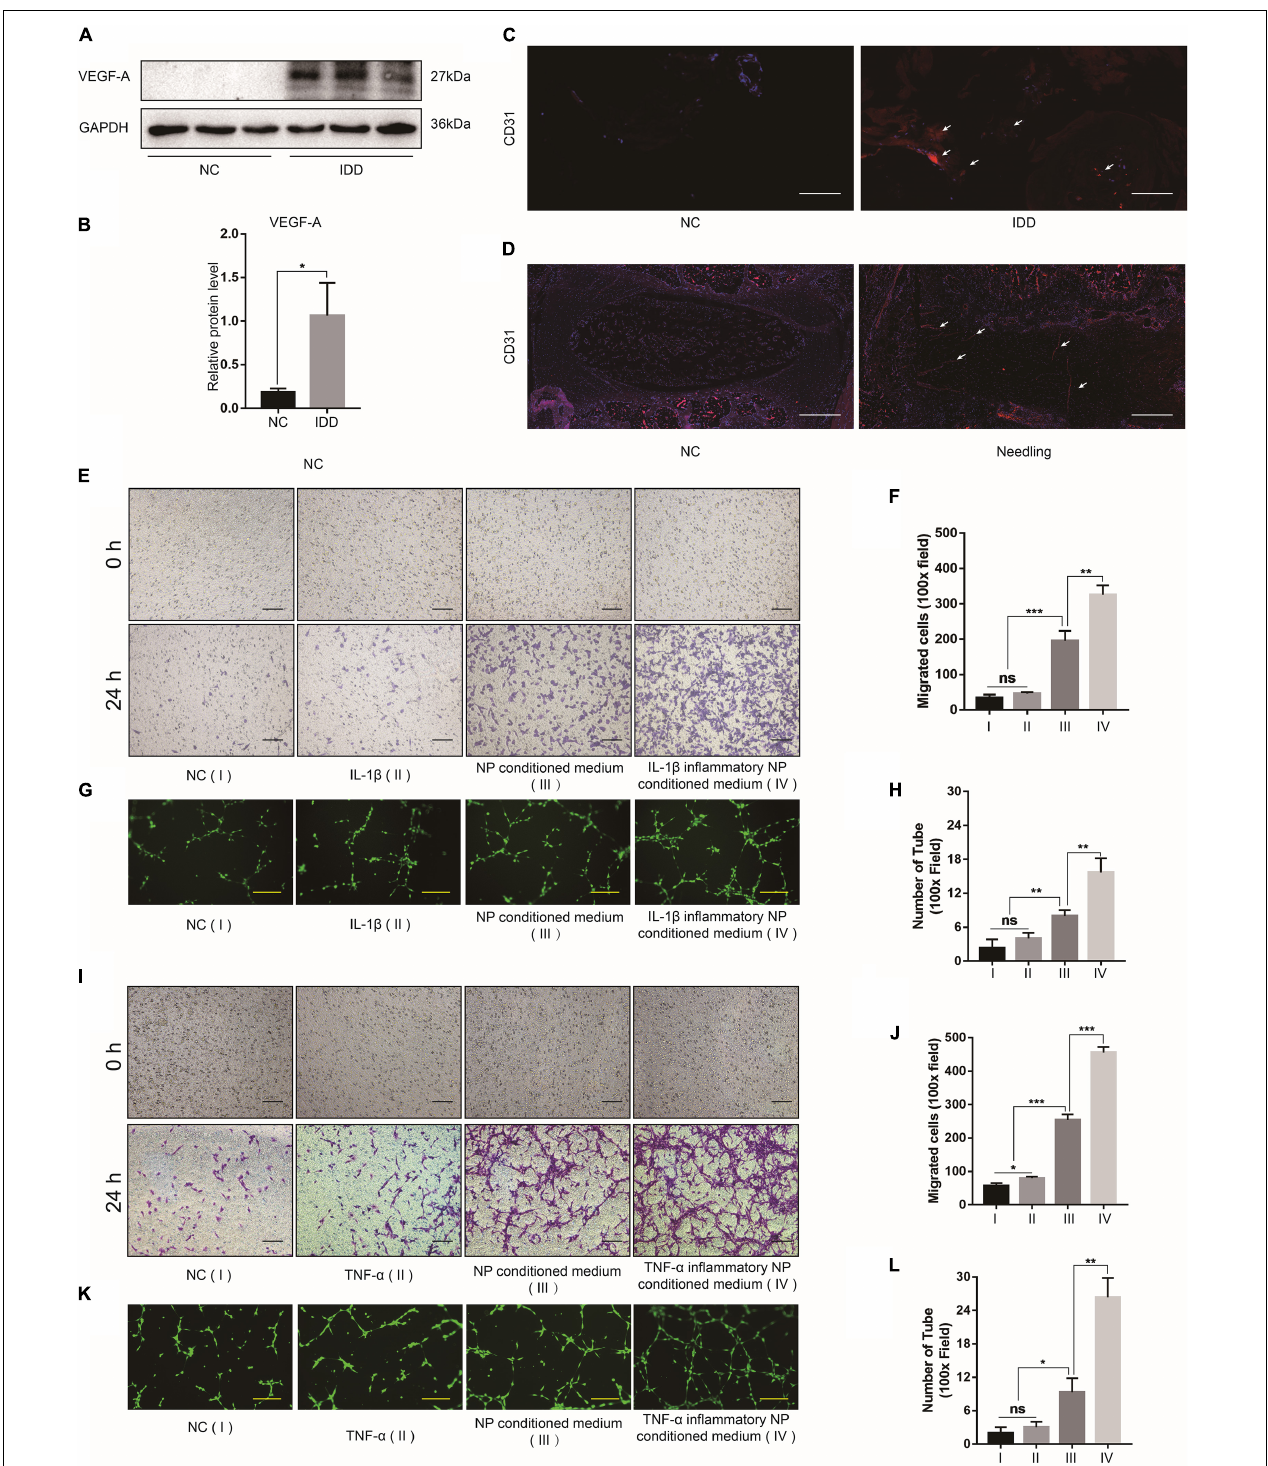
FIGURE 2 | Effects of degenerated NP cells on blood vessel function. (A) Representative western blot images of VEGF-A in human NP tissue and (B) its quantitative analysis. (C) CD31 IF images of human and (D) rat NP tissues. (E) Bright-field images of migrated EPCs after incubation with IL-1 β and (F) quantification by ImageJ. (G) Calcein-AM IF images of EPC tube formation assay after incubation with IL-1 β and (H) quantification by ImageJ. (I) Bright-field images of migrated EPCs after incubation with TNF- α and (J) quantification by ImageJ. (K) Calcein-AM IF images of EPC tube formation assay after incubation with TNF- α and (L) quantification by ImageJ. Black scale bar: 100 µ m. Yellow scale bar: 200 µ m. White scale bar: 500 µ m.